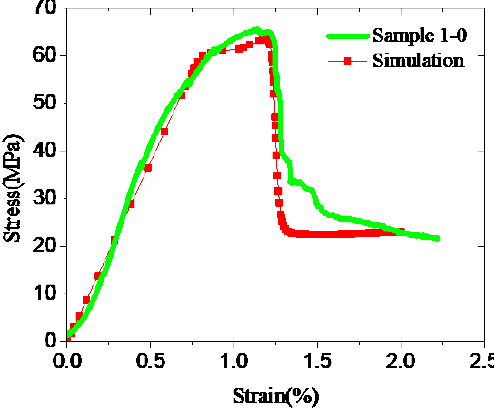
Figure 5. Simulation result and uniaxial test data of Sample 1-0.